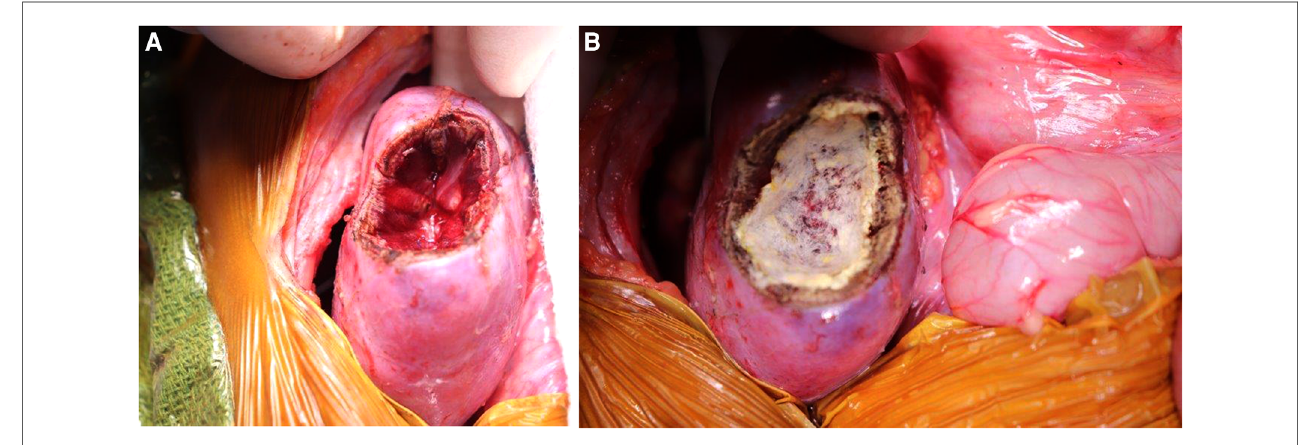
FIGURE 5 ( A ) Kidney defect following marginal resection of lesion. ( B ) Covering the surface of the defect with TachoSil to ensure